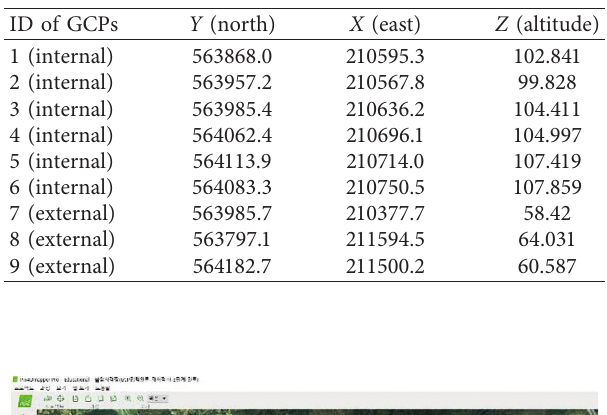
Table 1: Measured data of ground control points (GCPs) (in